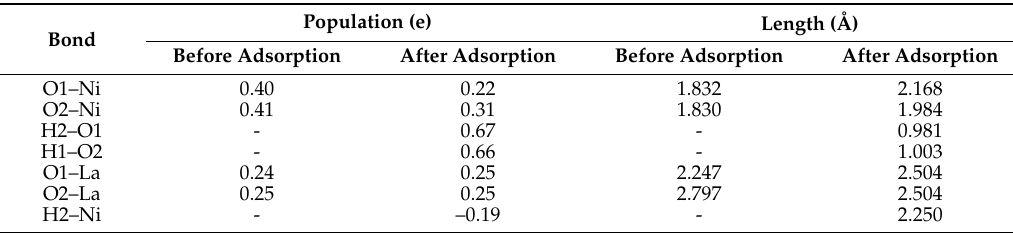
Table 6. The calculated bond populations of LaNiO 3 (001)/H 2 on B3 after adsorption.